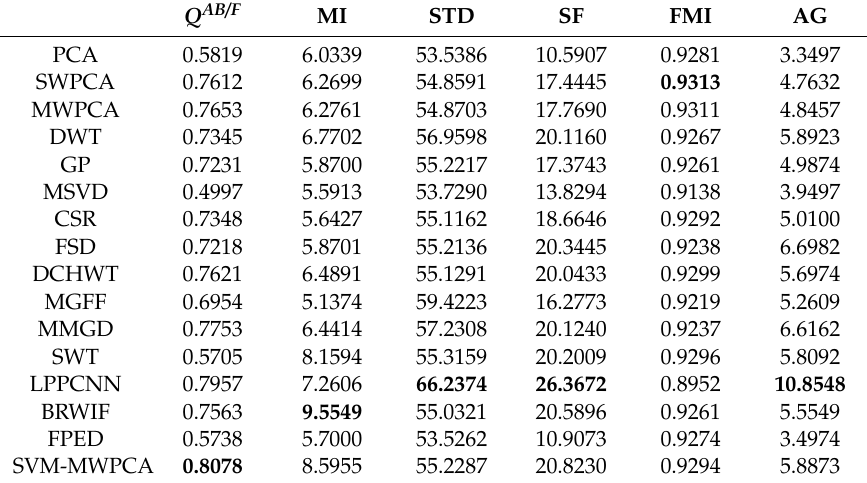
Table 4. Evaluation indexes of the fused images in source image pair “flora”.